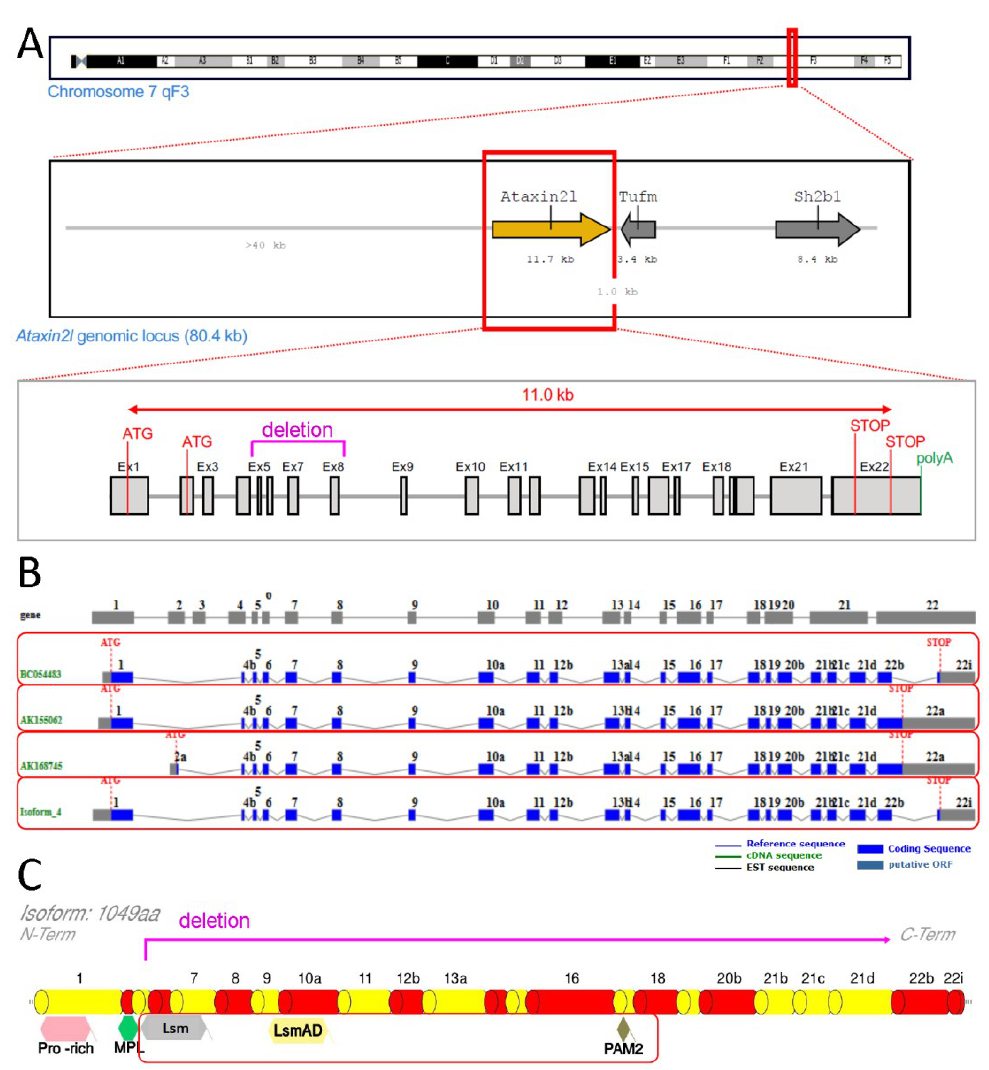
Figure 1. Scheme of genetic ablation within Atxn2l , with its splicing and translation e ff ects. Ataxin-2-like ( A ) at the DNA level with neighbor genes Tufm and Sh2b1 , indicating the deletion region in letters and lines of magenta color (also showing alternative translation start codons (ATG), structure from exon 1 to exon 22 with introns, alternative translation STOP codons, start of poly(A) tail); ( B ) at the mRNA level with alternatively spliced isoforms in separate red boxes; ( C ) at the protein level with relevant known sequence motifs (pro-rich refers to proline-rich-domain, MPL motif was reported by Meunier et al. 2002), highlighting the phylogenetically conserved Lsm, LsmAD and PAM2 motifs in a red box (deletion and frameshift are limiting translation to an N-terminal fragment until magenta line). The absence of ATXN2L protein epitopes from residue 150 until residue 1050 was confirmed in Atxn2l − / − mouse embryonal fibroblast (MEF) (Figure 2A). ATXN2L abundance was higher in cerebral cortex than in cerebellum. While MEFs showed two specific ATXN2L bands in immunoblots, in brain tissue the larger band dominated (Figure 2B). The separate quantification of several Atxn2l mRNA exon junctions, namely 7-8 to represent the deleted region, 10-11 further downstream, and 1-2 upstream − / − versus the alternatively spliced 1c-2 suggested the Atxn2l limb cells to sense the loss-of-function and either trigger the Atxn2l promoter or minimize the Atxn2l mRNA decay, thus maximizing the levels of the main Atxn2l mRNA variant. This feedback did not occur in MEF lines that are maintained in nutrient abundance (Figure 2C), suggesting that deprivation of overall energy or specific nutrients modulates Atxn2l